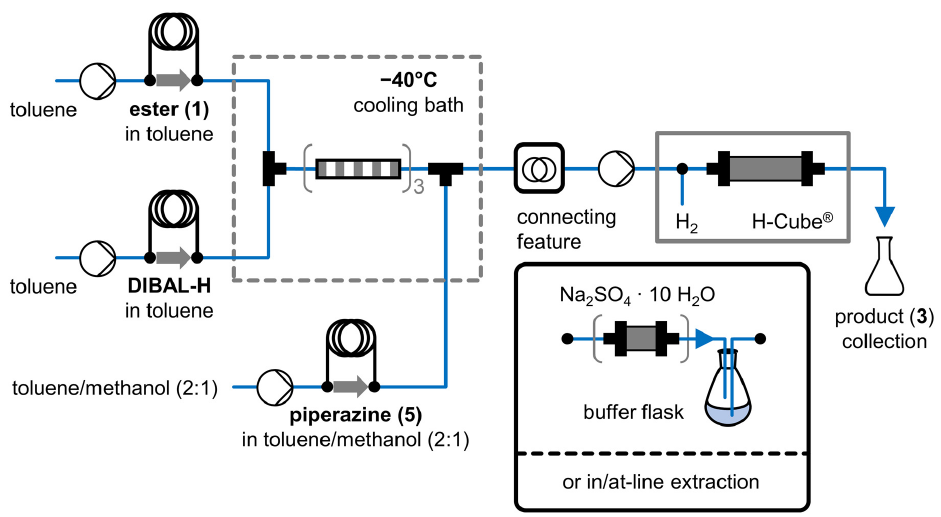
Figure 3. The schematic figure of the two-step consecutive